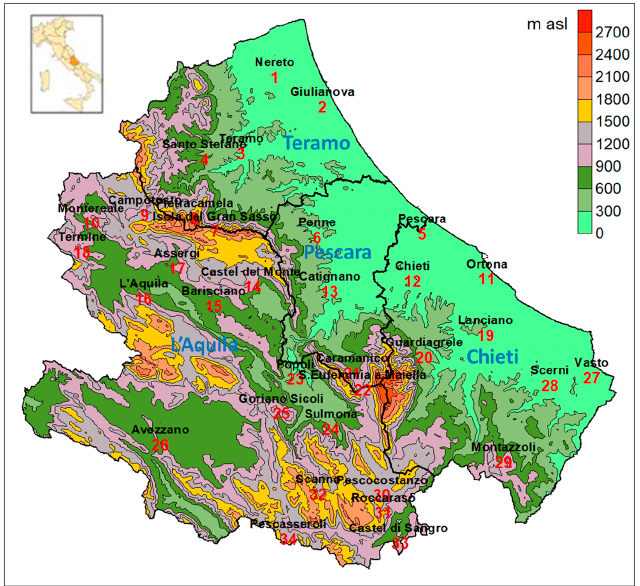
Figure 1. Map of the Abruzzo Region with the names and numeric codes of the 34 meteorological stations and, on the upper right, the altitude classes. The names of the administrative provinces are in blue for each area. The map of Italy with the location of the Abruzzo Region is on the upper